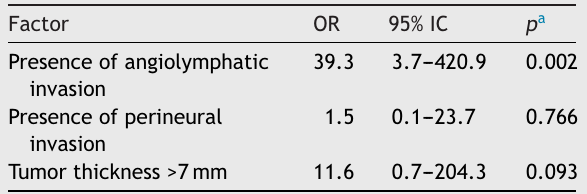
Multivariate analysis of risk factors for the pres- ence of occult lymph node